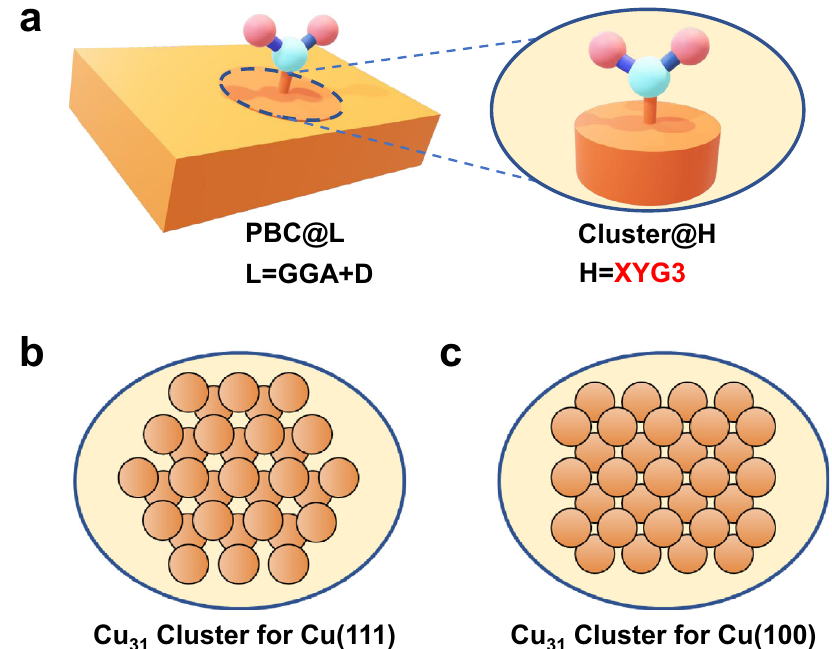
Fig. 2 | Hierarchy of models and methods for adsorption energy calculations. a Thedelocalizationeffectsoftheextendedmetalsurfacearetakenintoaccountby an ef fi cient periodic boundary condition (PBC) calculation as the basic low level (PBC@L) at the GGA level with the dispersion correction (L=GGA+D), while the calculations on the metal-adsorbate interactions are then updated to the target